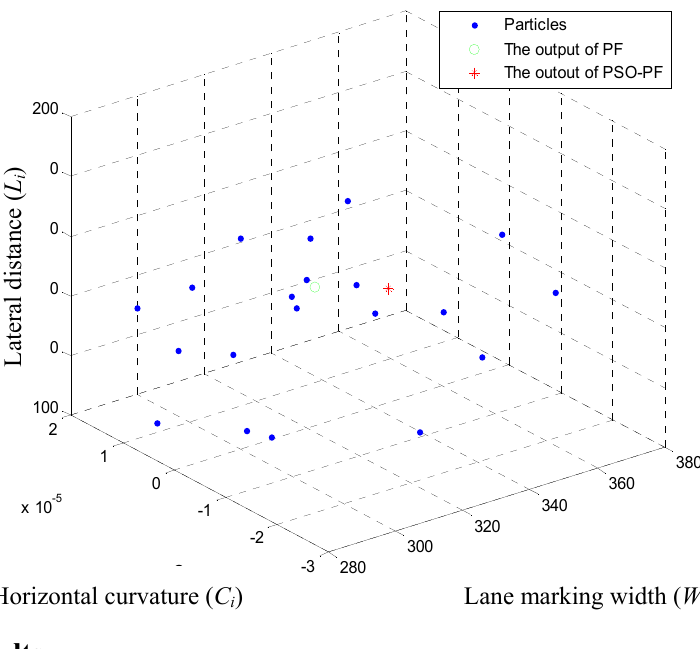
Figure 5. Particle Distribution Example ( N =